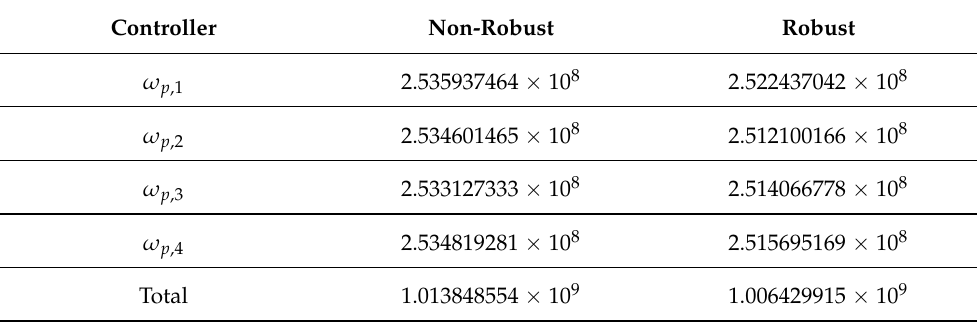
Table 5. Actuation effort of robust and non-robust controllers as propeller angular velocity square integral along all the mission